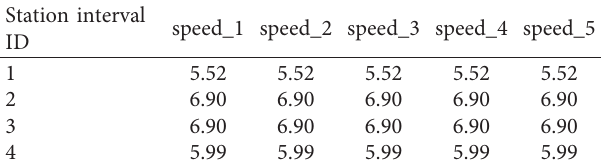
Table 4: Speed data.